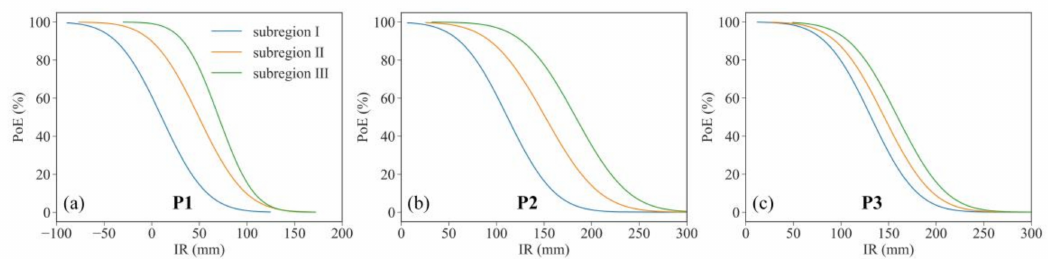
Figure 4. Probability of exceedance (%) of irrigation requirements (IR) in P1 ( a ), P2 ( b ) and P3 ( c ) stages of winter wheat from 2000 to 2020 (negative value of IR indicates no irrigation